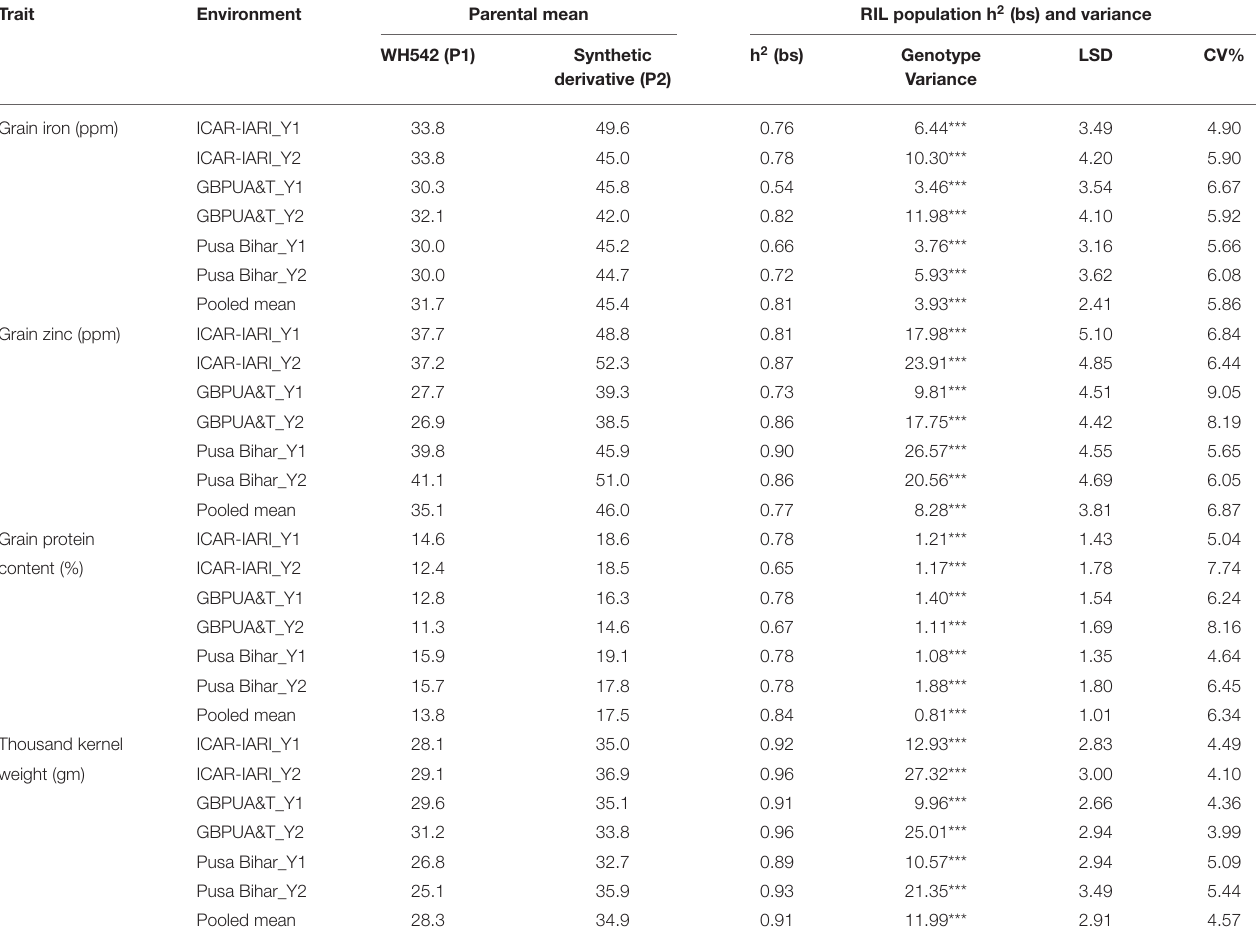
TABLE 1 | Heritability and variance components of grain iron, zinc, protein, and thousand kernel weight in RIL population grown across three locations for 2 years.